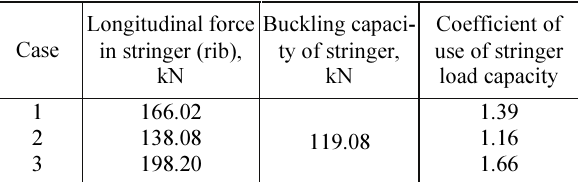
Table 5. Use of stringer load capacity